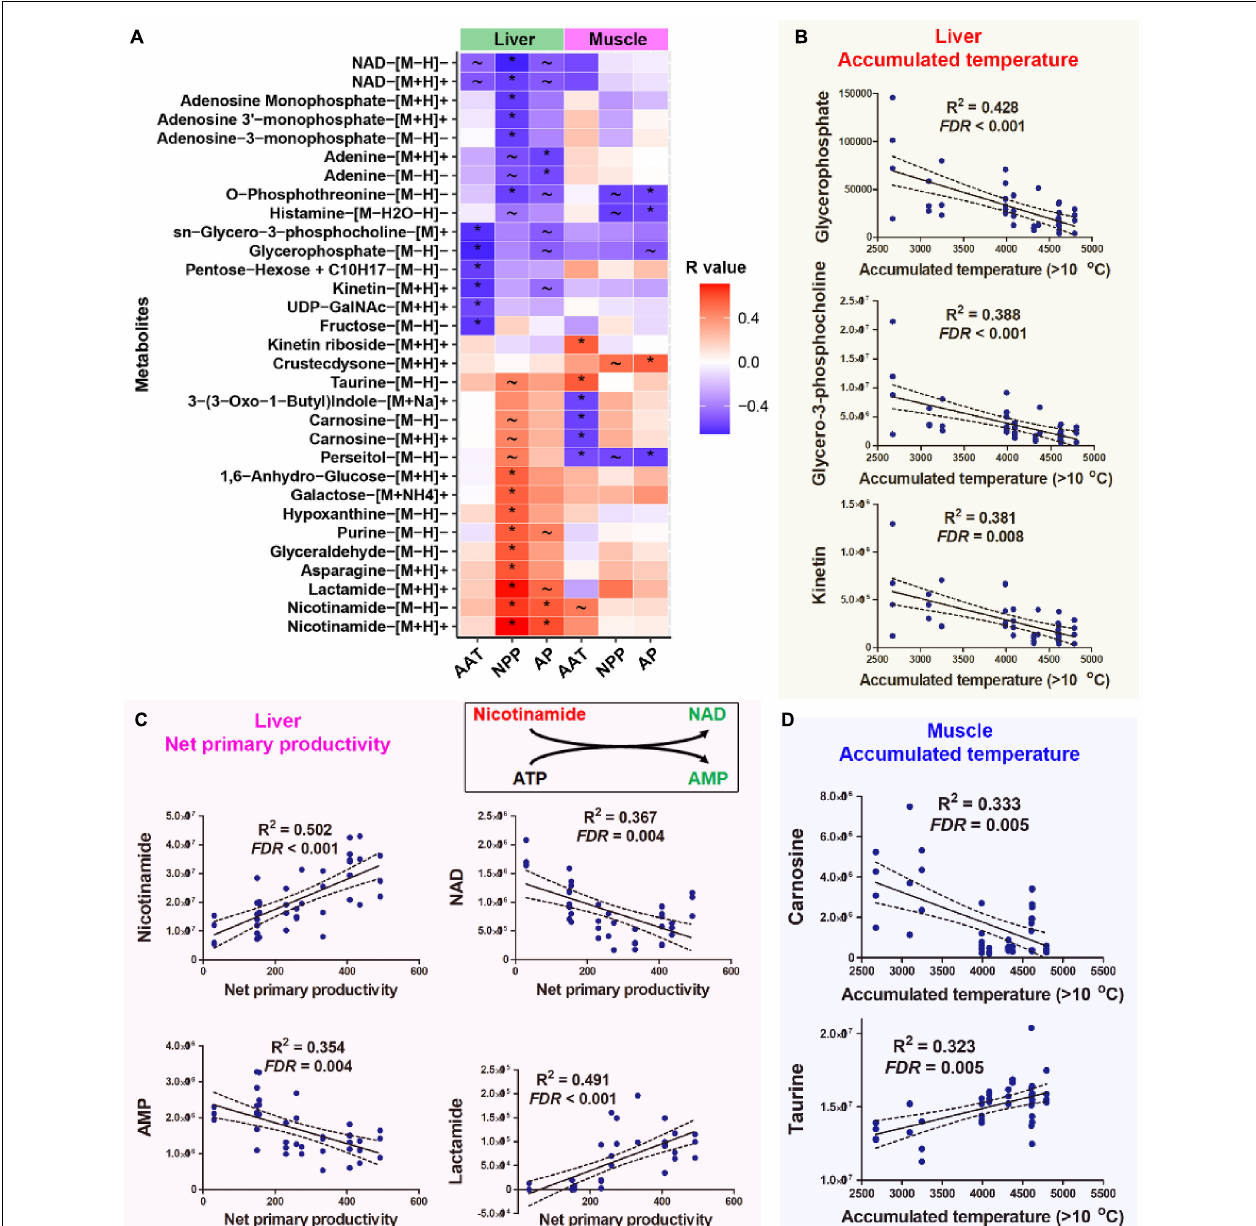
FIGURE 3 | Host metabolites associated with climatic factors. (A) Heatmap presenting the correlations ( R -value) between host metabolites and climatic factors. Climatic factors were limited to those contributing significantly to the variations in organ metabolome ( p < 0.05, PERMANOVA). The metabolites presented were significantly correlated with ( q < 0.01, Pearson correlation; p < 0.05, Spearman correlation) at least one climatic factor. * q < 0.01 for Pearson correlation and p < 0.05 for Spearman correlation; ∼ q < 0.05 for Pearson correlation and p < 0.05 for Spearman correlation. (B) Correlations between AAT and liver metabolites. (C) Correlations between NPP and liver metabolites. (D) Correlations between AAT and muscle metabolites. The abundances of metabolites were presented as peak area, which had no